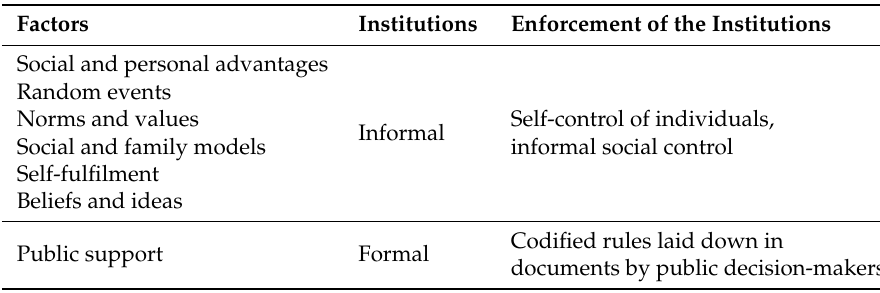
Table 4. Institutional factors on engagement in the social